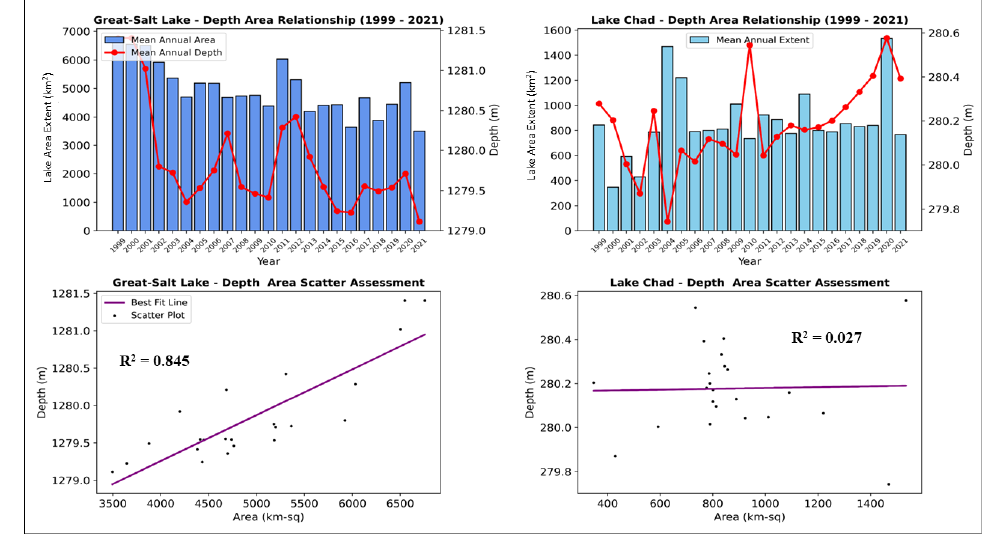
Figure 8. Temporal variation of annual lake area and water depth in GSL ( top left ) and LC ( top right ), and linear regression results between the lake area and water depth of GSL ( bottom left ) and LC ( bottom right ).